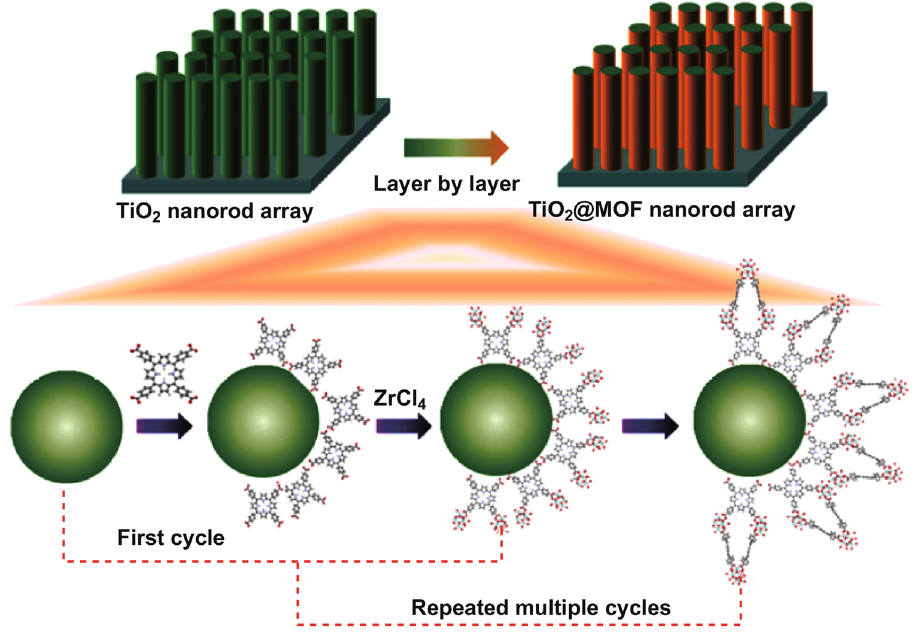
Fig. 30 Synthesis of TiO 2 @MOF nanorod array photoanode through layer-by-layer method. Reprinted with permission from Ref. [28]. Copy- right 2018, Springer